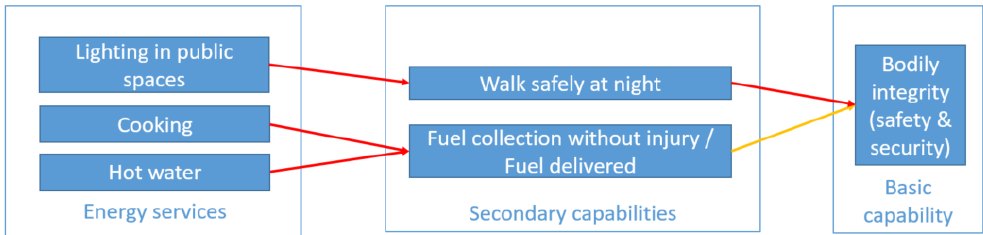
Figure 3. Connections made between energy services, secondary capabilities and bodily integrity.